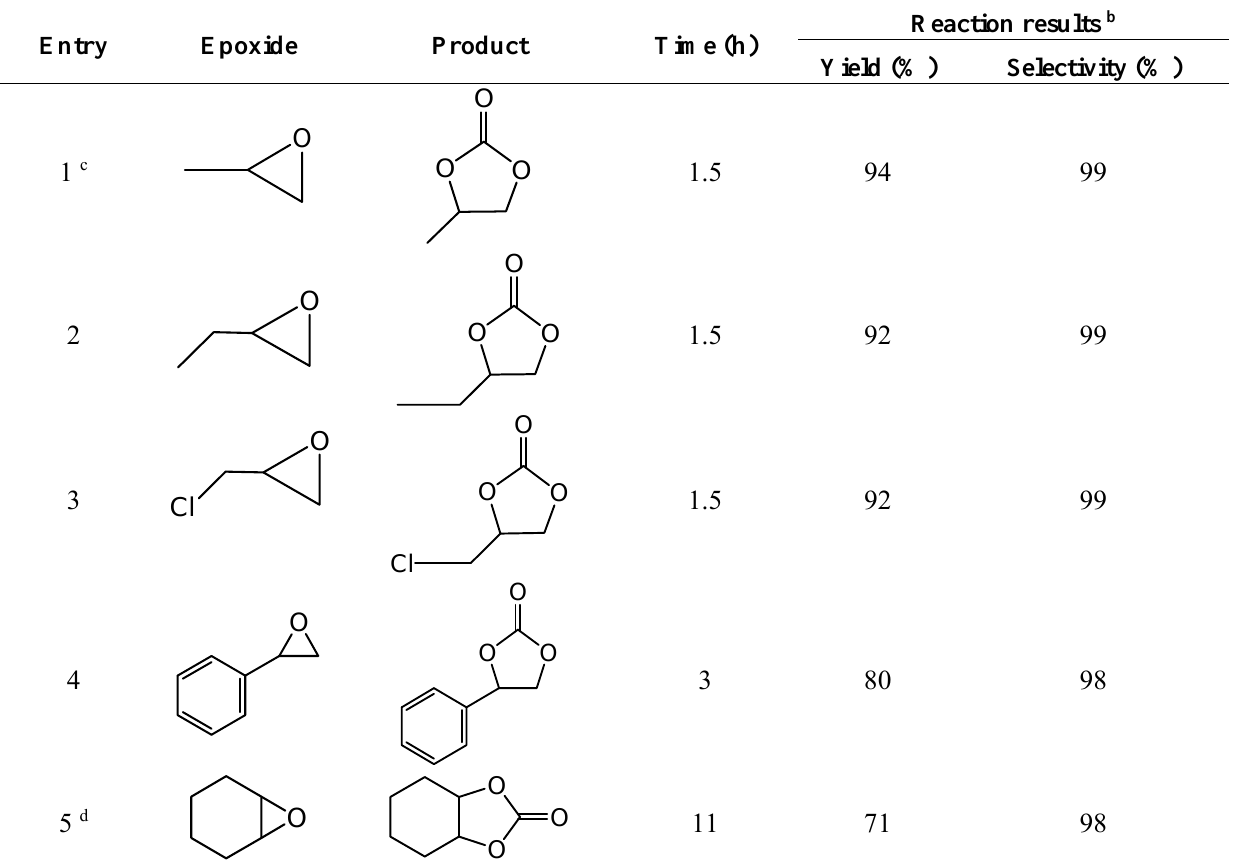
Table 2. Catalytic activity of CO 2 cycloaddition to various epoxides a